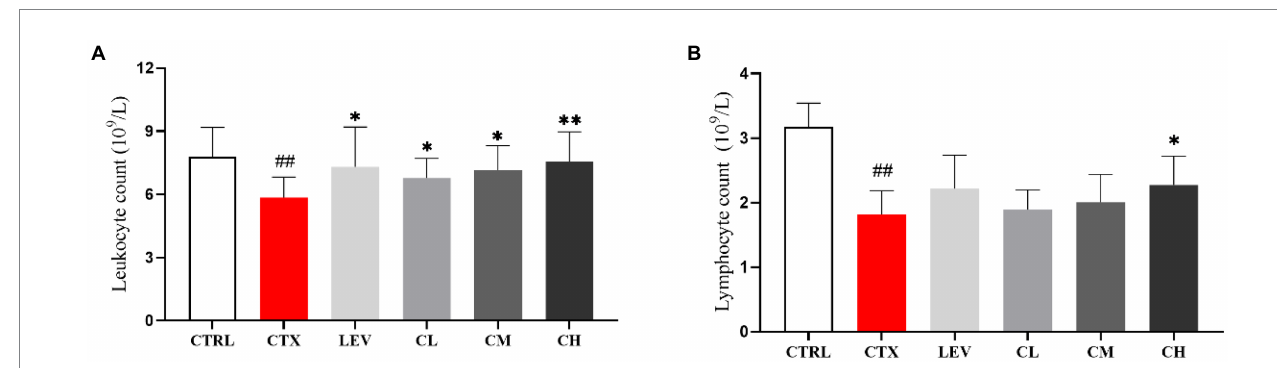
FIGURE 3 Complex probiotics adjusted (A) leukocyte count and (B) lymphocyte count in CTX-induced immunosuppression mice. ( n = 8 for each group). CTRL, normal control group; CTX, model control group; LEV, levamisole hydrochloride; CL, low-dose complex probiotics; CM, Medium-dose complex probiotics; CH, high-dose complex probiotics. All data are expressed as mean ± SD. # p < 0.05, ## p < 0.01, ### p < 0.001 compared with CTRL; * p < 0.05, ** p < 0.01, *** p < 0.001 compared with CTX.